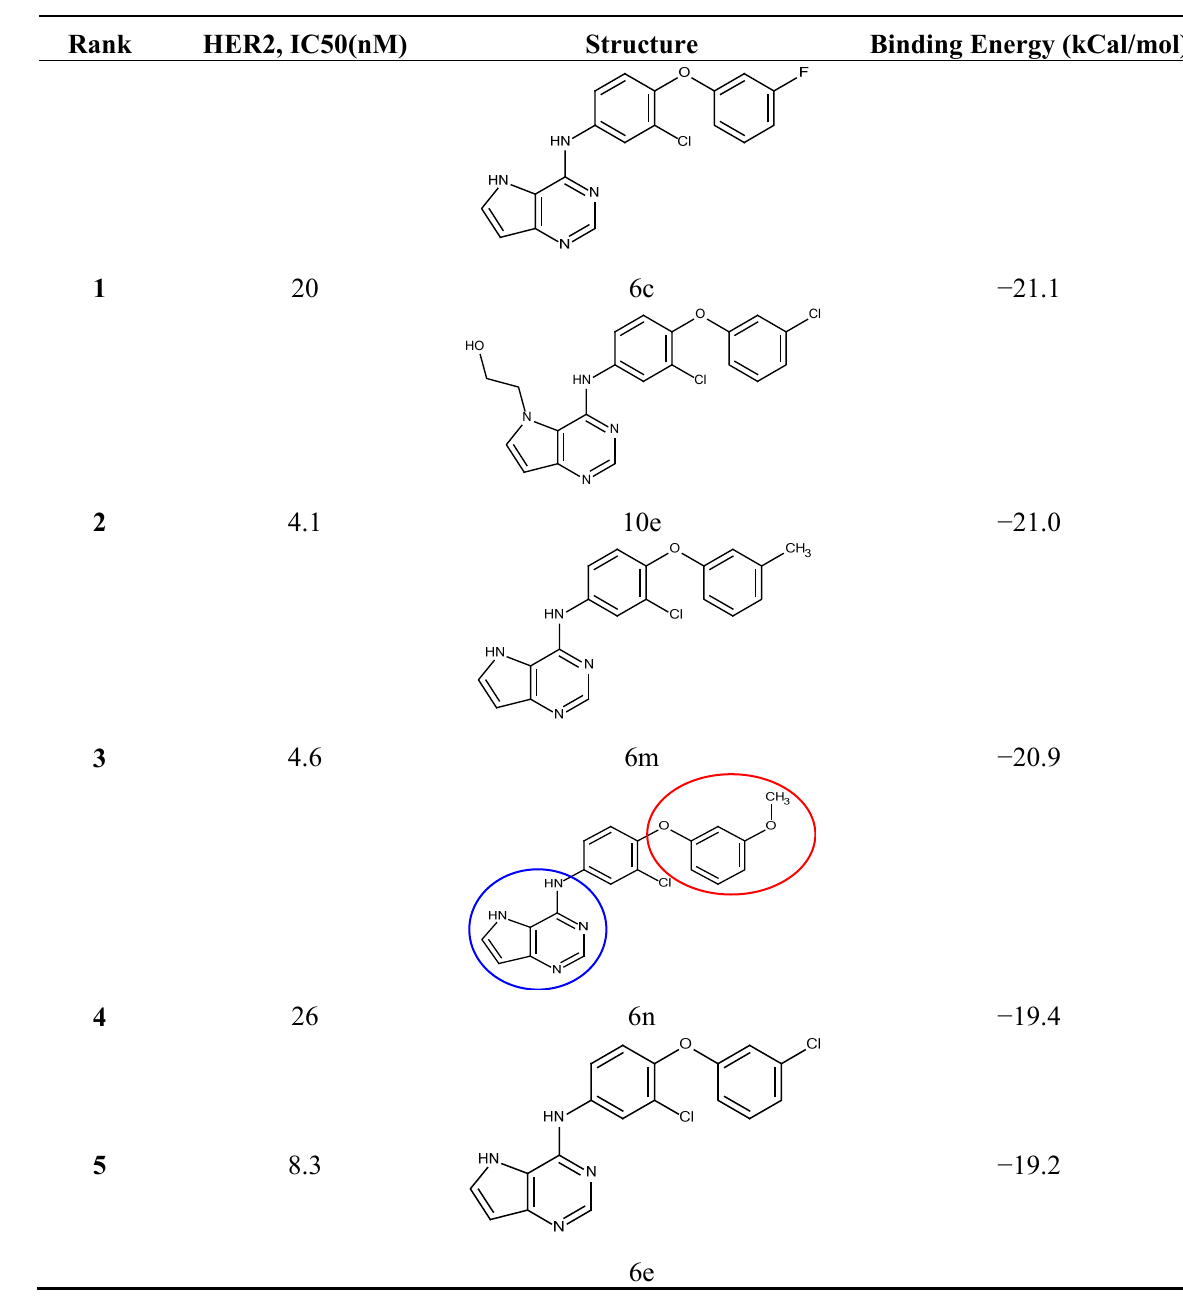
Table 3. Ranking of TAK-285 analogues of compound after optimization. The ellipses define fragments of for each site in Compound 6n ; blue for fragment 1 and red for fragment